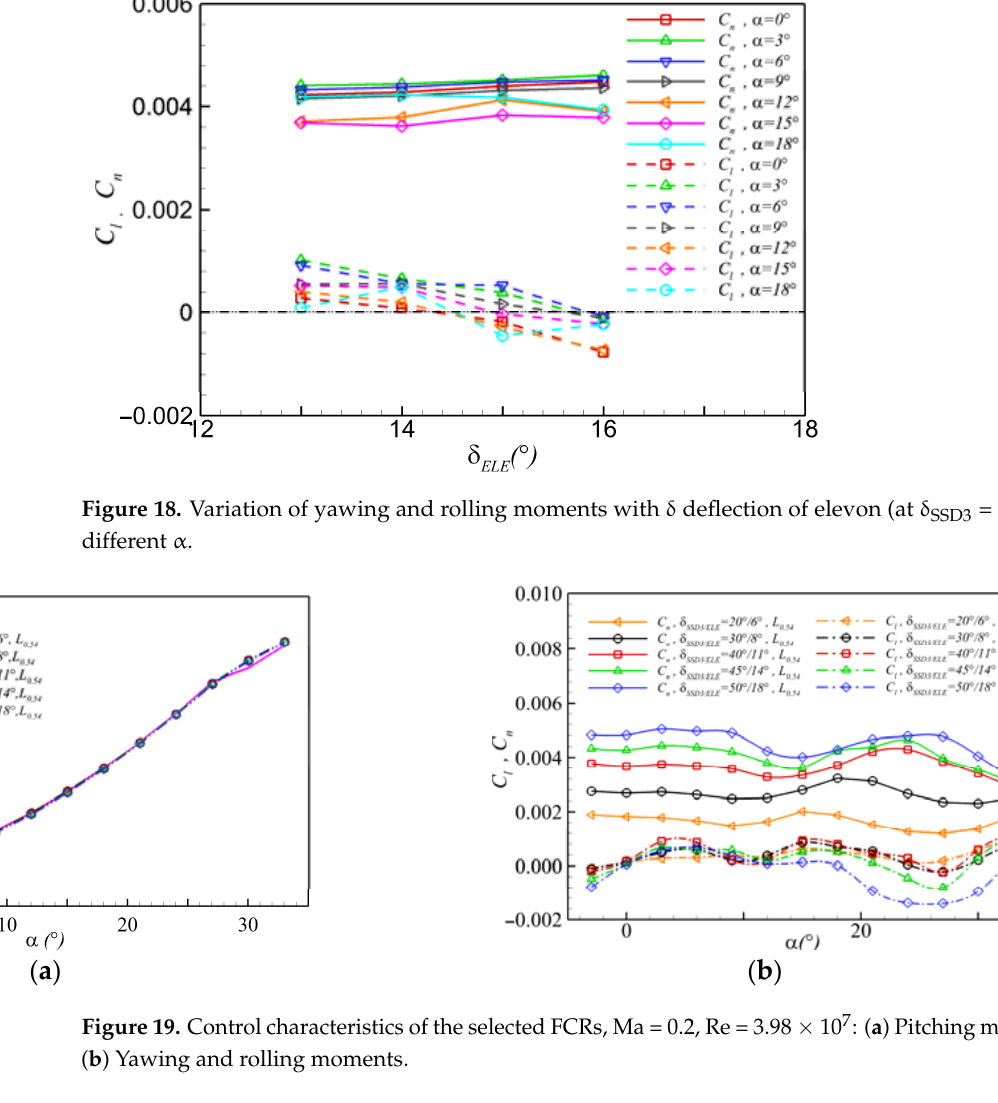
Figure 17. Control characteristics of the FCRs with different collocating deflection angles, Ma = 0.2, Re = 3.98 × 10 7 : ( a ) Yawing moment; ( b ) Rolling moment.